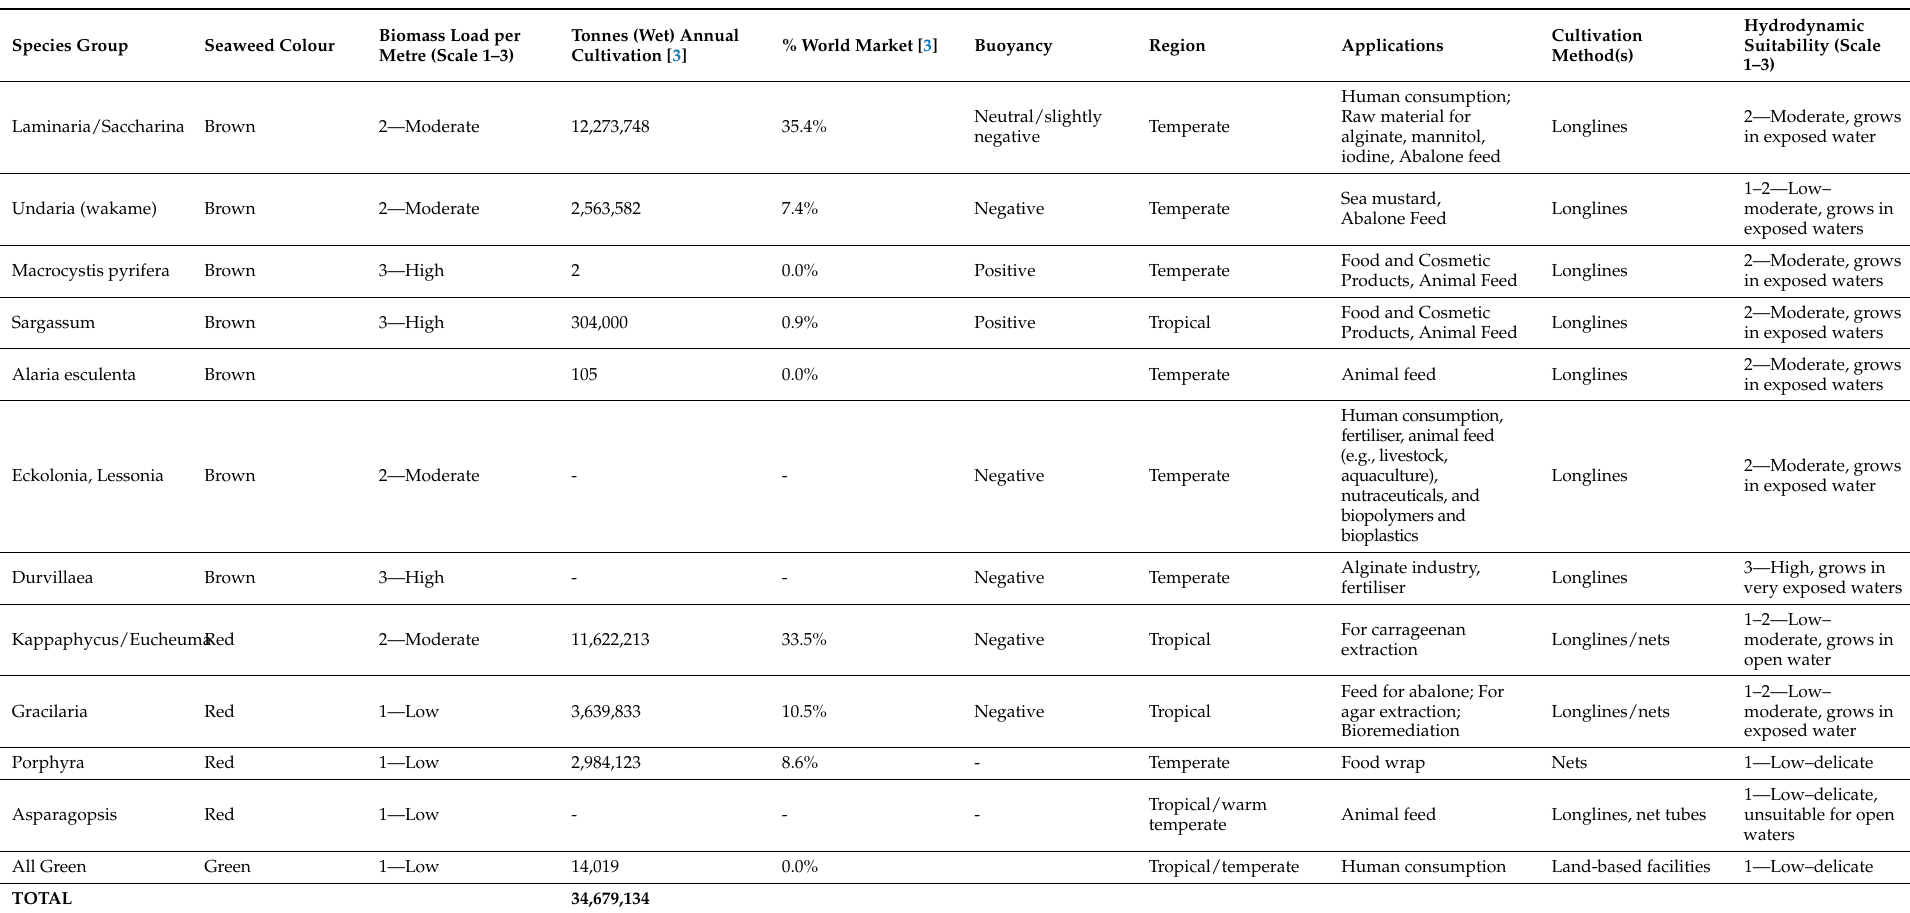
Table 2. Seaweed species use and